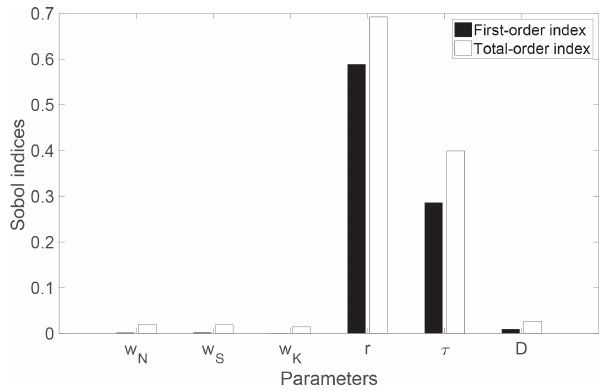
Figure 4. Sobol sensitivity indices for the six Demeter parameters. Higher indices indicate higher